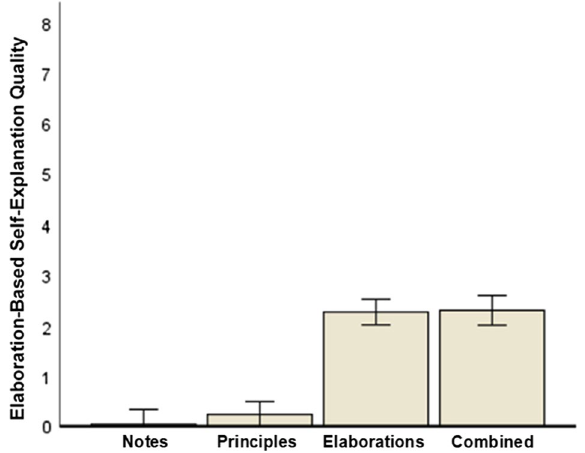
Fig. 2 Elaboration-based self-explanation quality with respect to prompt type. Error bars: 95%